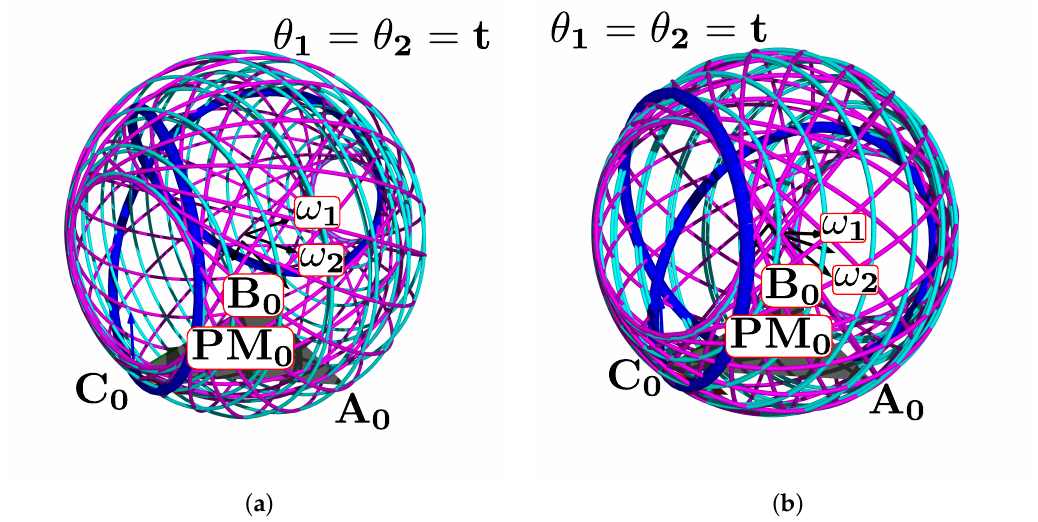
Figure 28. Simulation results for C: ( a ) mean values plus 10%, ( b ) mean values minus 10%. Finally, by changing the range of maximum and minimum angles, an example of the interactive simulation is in Figure 29a,b. We capture the view of the sliders and also show the simulation rendering